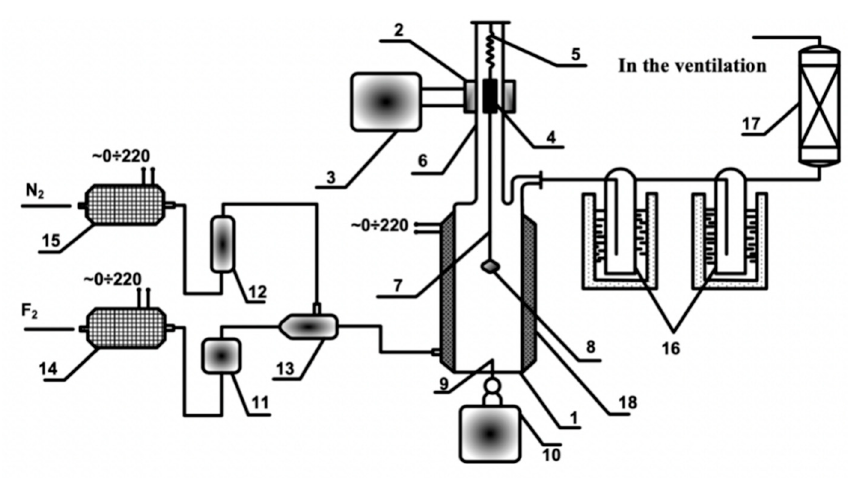
Figure 1. Diagram of setting up testing system of fluorination processing of Rutile concentrate [19]. 1—Fluorination reactor; 2—induction coil; 3—registering device; 4—electromagnetic coil; 5—spring made of Мо ; 6—measuring device; 7—molybdenum string; 8—cup from a nickel foil; 9,10—system of temperature controlling and checking; 11,12—gas charging controlling system F 2 and N 2 ; 13—mixture of fluorine and argon supply; 14,15—heaters of fluoride and argon; 16—condensers; 17—sorption column; 18—electric heater.